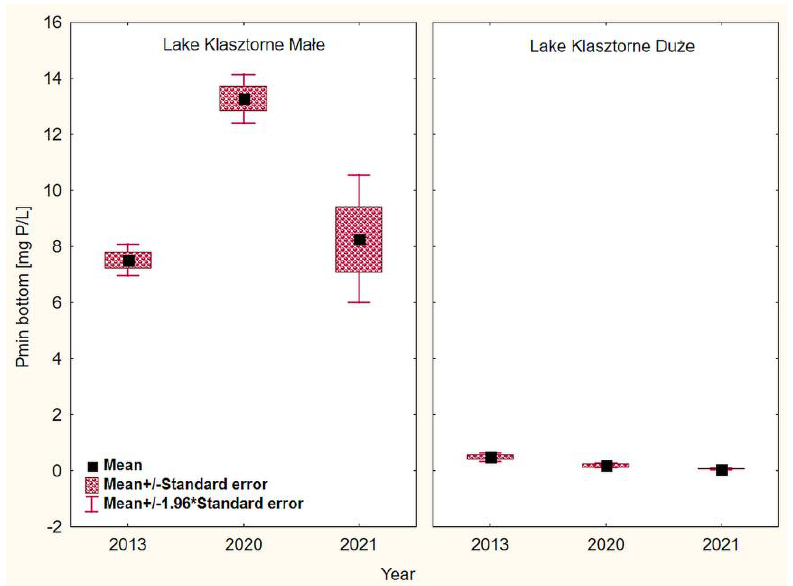
Figure 7. Average annual values of mineral phosphorus (P min .) in the bottom water of Klasztorne lakes in selected research years.